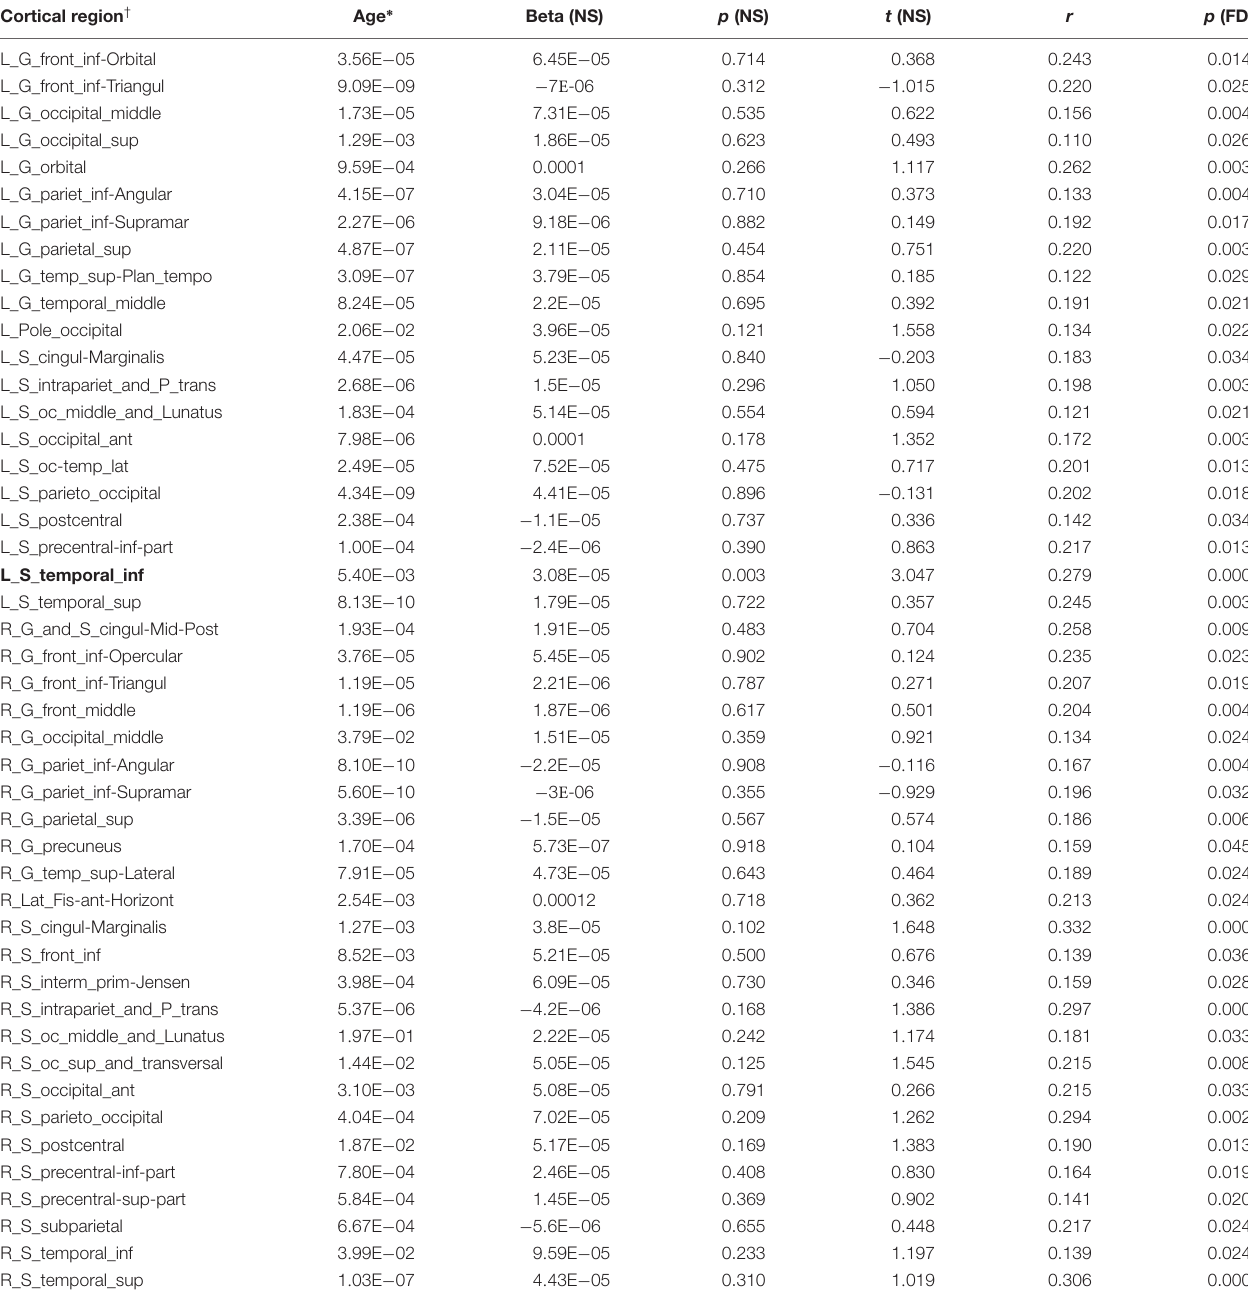
TABLE 7 | Dehydroepiandrosterone sulfate association with cortical